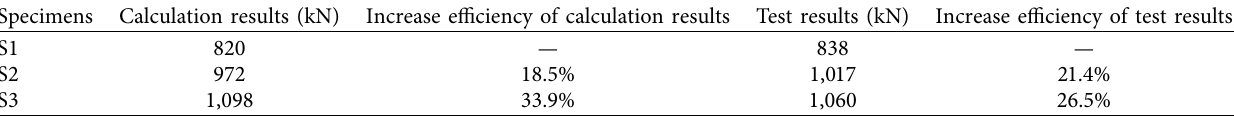
Table 4: Comparison of calculation and test results of ultimate bearing